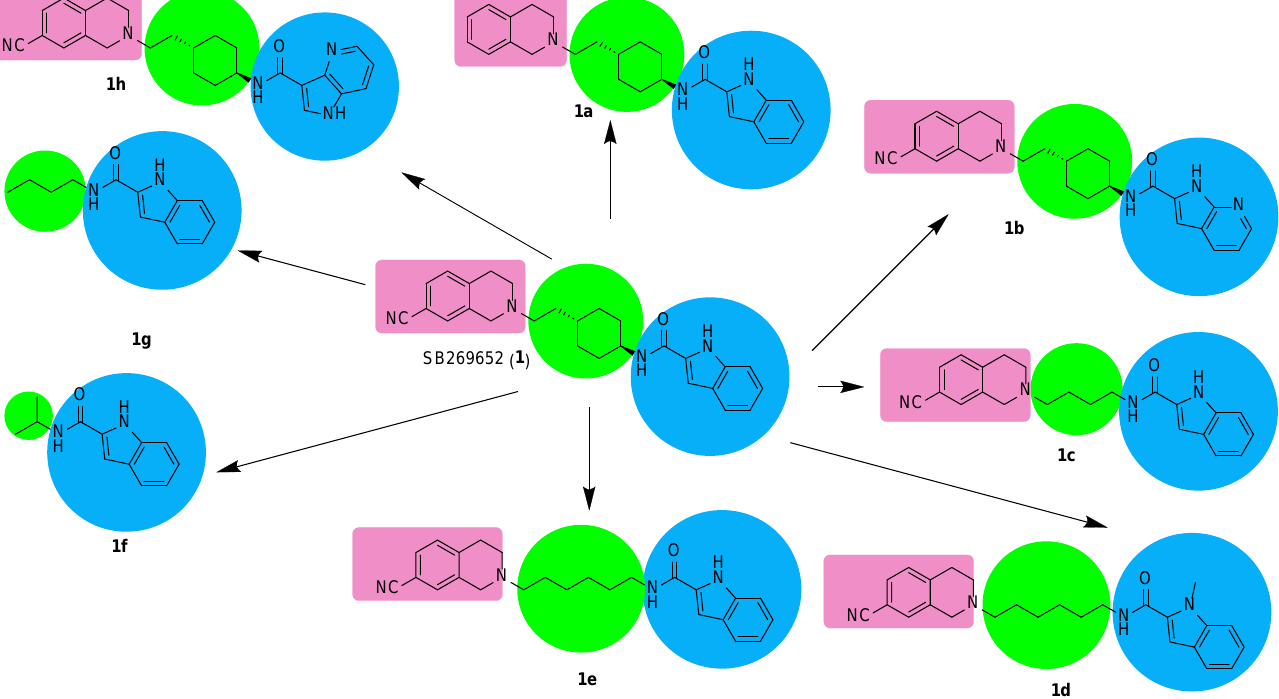
Figure 1. SB-269652 analogues with different motifs. Blue motif binds to the allosteric site, pink binds to the orthosteric site and green is the linker.